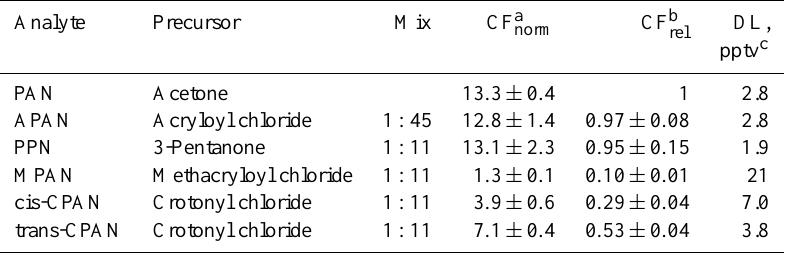
Table 1. Summary of calibration factors (CFs, Hzpptv − 1 ) relative to PAN using results from the calibration mixture. The mix ratio rep- resents the volumetric mixing ratio of precursor compound to tridecane used and is held constant for both single-component mixtures and multicomponent mixtures.